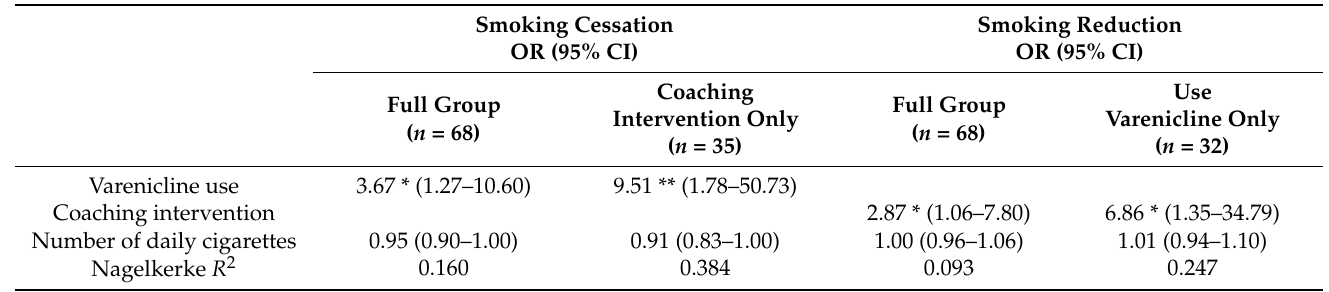
Table 4. Result of logistic